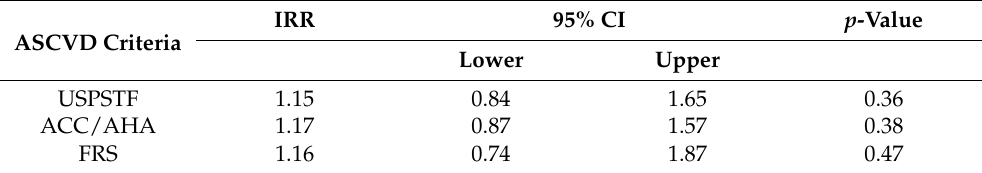
Abbreviations: ASCVD = Atherosclerotic Cardiovascular Disease, CI = Confidence Interval, FRS = Framingham Risk Score, IRR = incidence rate ratio, PCE = Pooled Cohort Equation, USPSTF = United States Preventive Services Task Force. Table 7. Poisson regression analysis, outcome—ASCVD event.